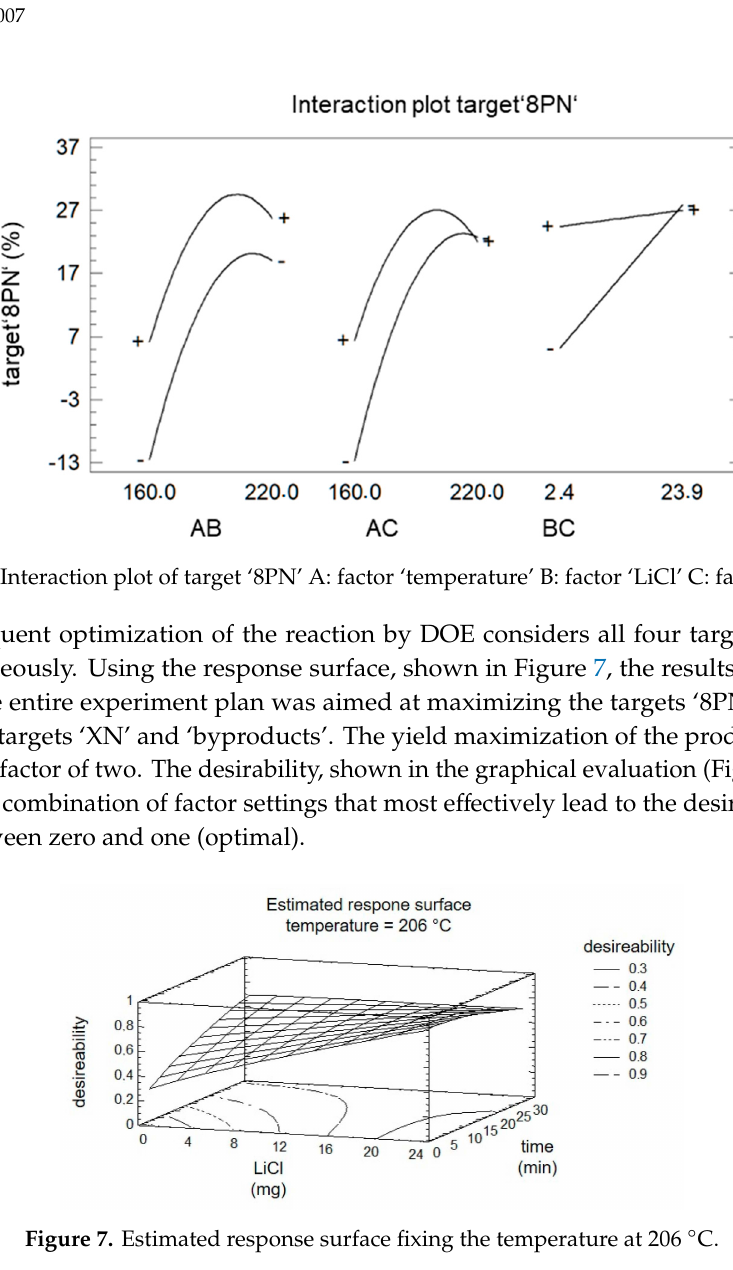
Figure 7. Estimated response surface fixing the temperature at 206 °C.